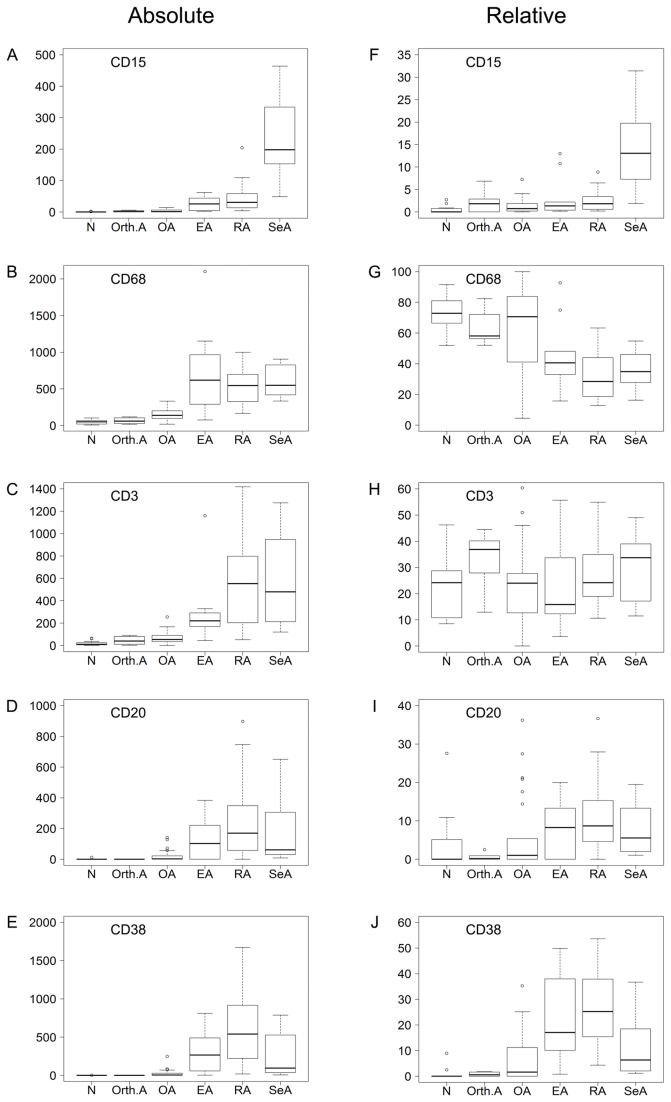
Box plots comparing absolute and relative cell densities in the 6 sample groups.Synovial tissue sections were stained immunohistochemically for CD15, CD68, CD3, CD20, and CD38. The absolute cell densities (left half of the page, labeled “Absolute”, Panels A-E) are expressed as the number of positive staining cells per mm2. The relative cell densities (right half of the page, labeled “Relative”, panels F-J) correspond to the cells expressing a given marker as a percentage of the inflammatory cell population, which is defined as the sum of all cells expressing any of the five markers, per mm2. Upper and lower borders of the box, 75th percentile and 25th percentiles; horizontal line, median; upper and lower whiskers, maximum and minimum; circles, outliers defined as values above or below the box by a >1.5-fold of the interquartile range.